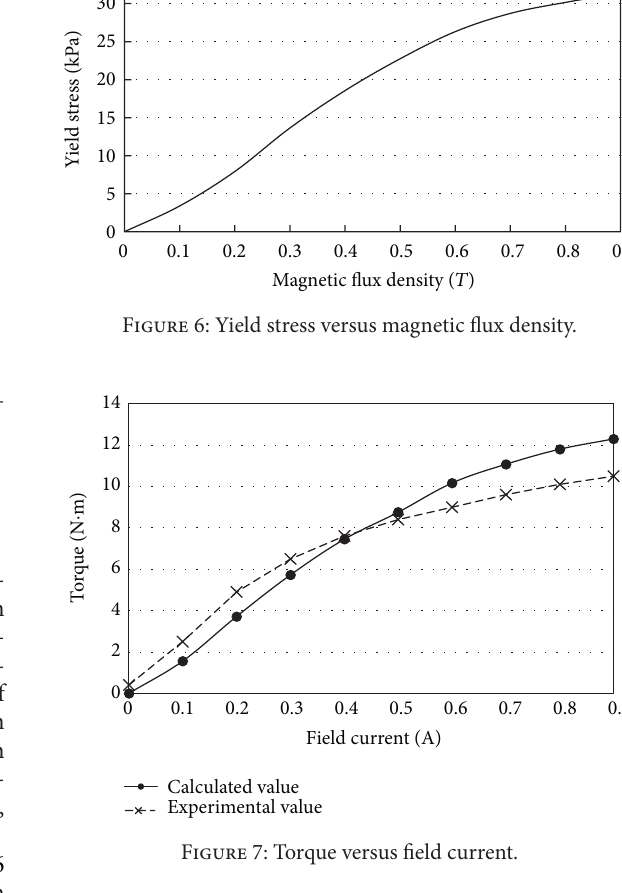
of transmit torque are 0.6 N ⋅ m, 4.9 N ⋅ m, 7.6 N ⋅ m, 9.0 N ⋅